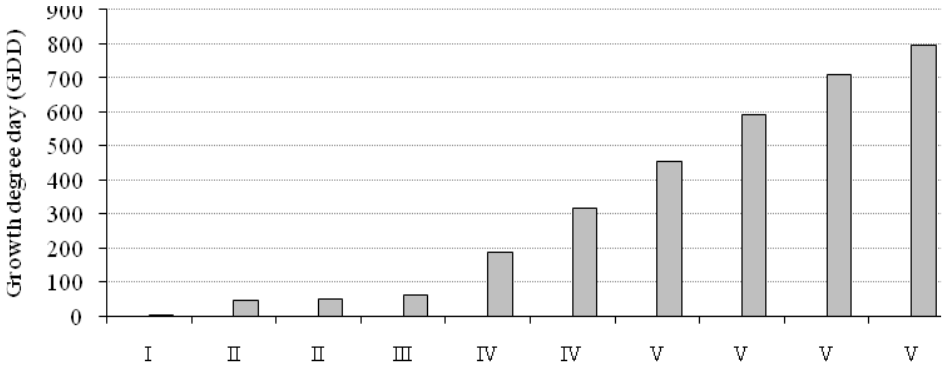
Fig. 4. Growth stages of ground cherry based on the growth index; I=Seedling; II=Juvenile; III= Flower bud-flowering; IV= Flower bud-flowering-fruiting; V= Flower bud-flowering-Fruiting -Seed